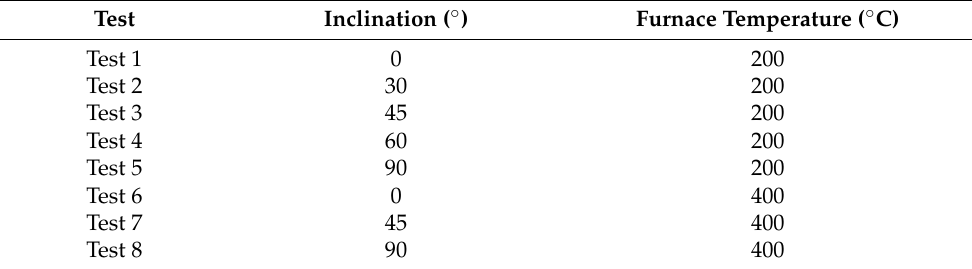
Figure 3. Thermal imaging of the frontal face. The test matrix is summarized in Table 2. Table 2. Summary of experiments and respective testing